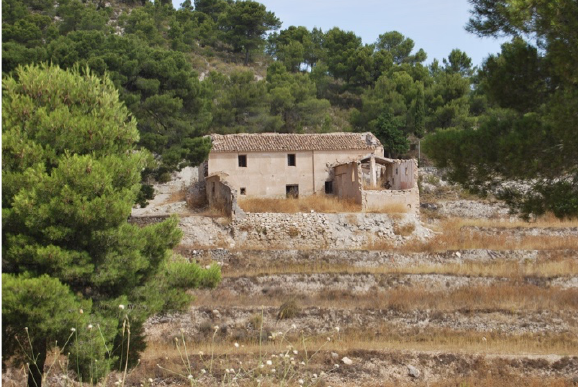
Figure 4. Mas del Litero . The dilapidated state is due to its abandonment and plundering